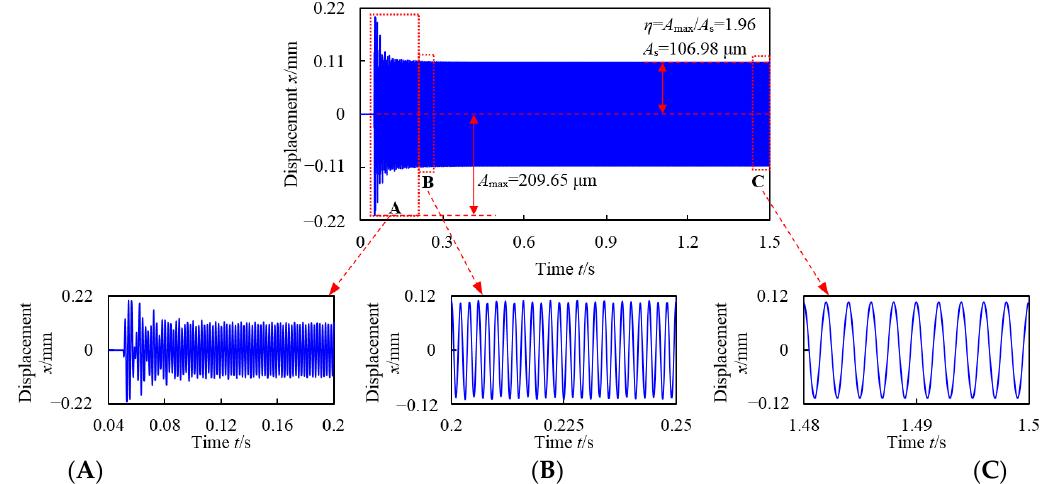
Figure 17. The time-domain response of 1# bearing in the horizontal direction when the rotor operates at 30,000 r/min: ( A ) 0.04–0.2 s; ( B ) 0.2–0.25 s; ( C ) 1.48–1.5 s.